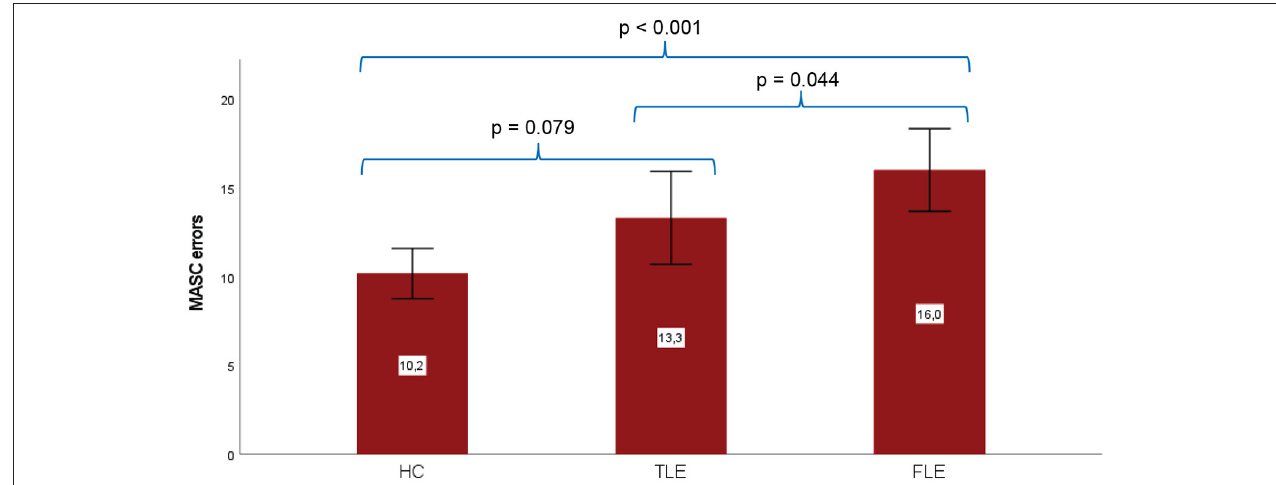
FIGURE 1 | ToM performance (MASC errors: higher values correspond to worse performance, mean values ± 2 standard errors shown on each bar) according to group status. Healthy controls ( N = 29), TLE patients ( N = 20) and FLE patients ( N = 10). MASC, Movie for the Assessment of Social Cognition. Significance levels for subgroup differences are shown prior to Bonferroni correction.